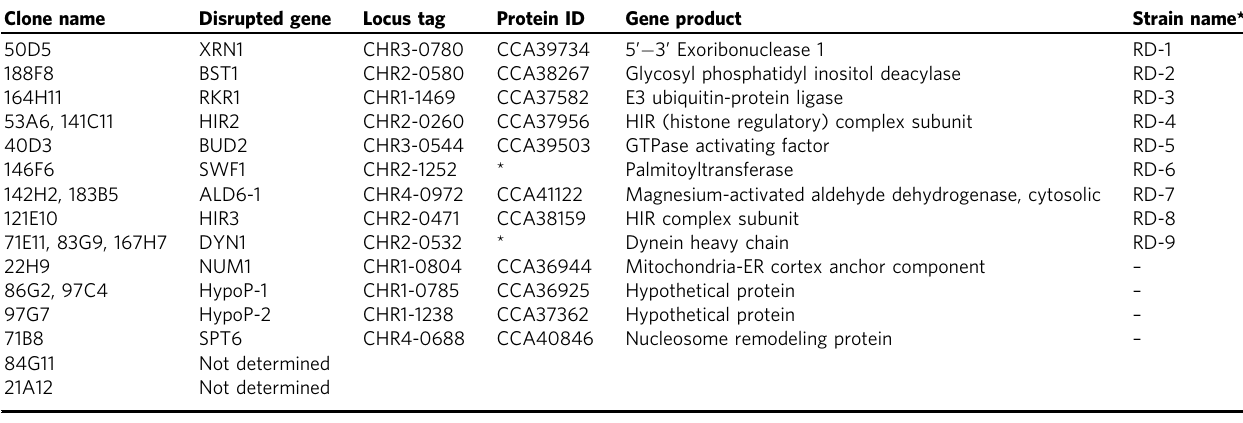
Table 1 Properties of higher scFv secreting strains obtained from the genome-wide screen. Clone